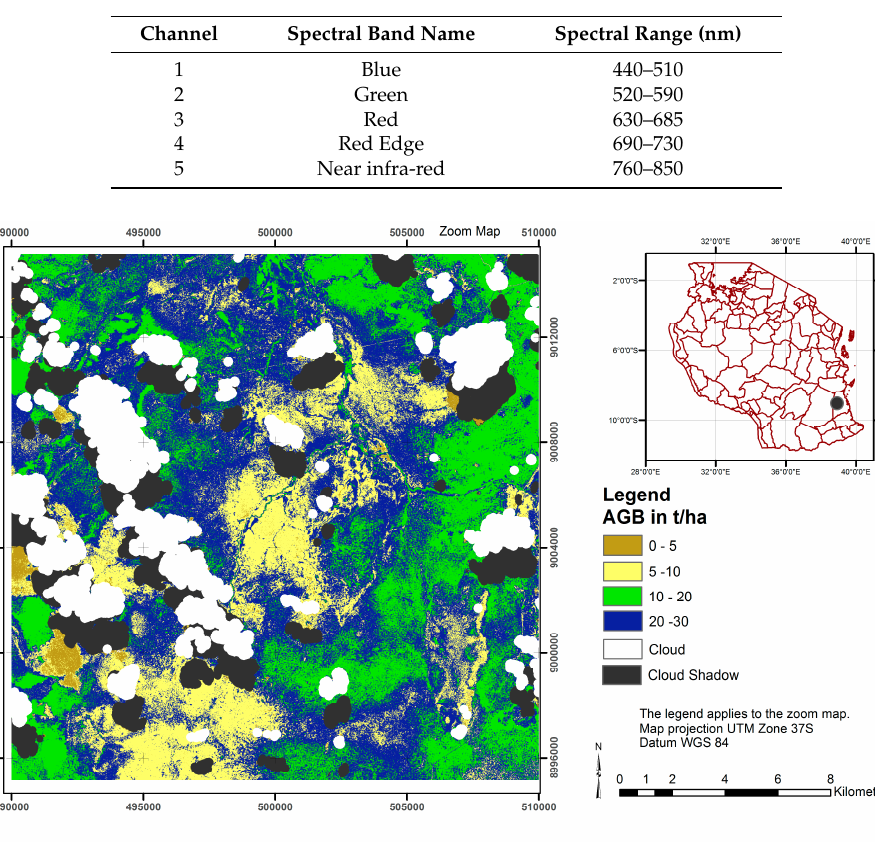
Table 2. RapidEye Spectral Channels.